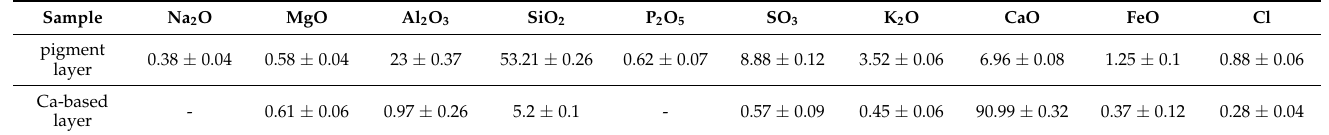
Table 3. EDS microanalysis ( w / w %) of pigment layer and the Ca-based layer of sample 1.